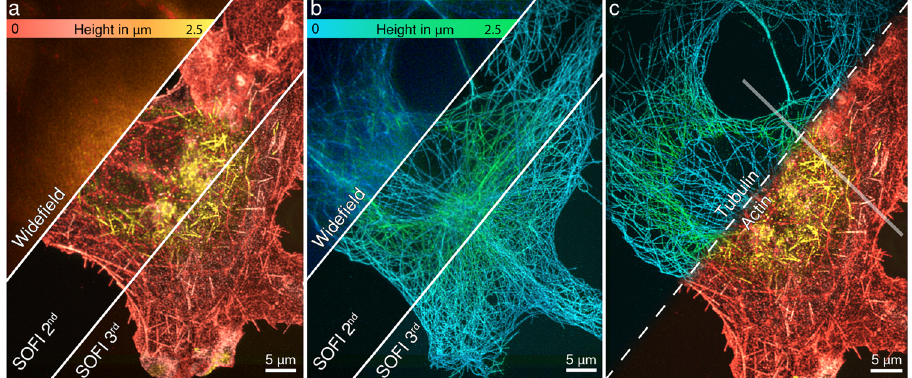
Fig. 3 Multi-plane 3D SOFI imaging of cytoskeletal components in a fi xed COS-7 cell. a 3D SOFI imaging of fi lamentous actin labeled with phalloidin conjugated to Alexa-647 and tubulin ( b ) labeled with the Abberior FLIP-565 self-blinking dye. A sample volume of 2.45 μ m × 65 μ m × 55 μ m was recorded with 8 equally spaced physical planes, resulting in 22 image planes after 3 rd order SOFI processing. Flat- fi elded 635 nm and 532 nm laser lines were used for the excitation. Alexa-647 dye was imaged in reductive/oxidative system imaging buffer with 10 mM mercaptoethylamine, while the Abberior FLIP-565 dye was imaged in a 50% glycerol and PBS solution at pH = 7.5. Height is represented in color scales displayed for each channel. c Co-registered 3D 3 rd order SOFI volumes of tubulin and fi lamentous actin. Co-registration was performed based on bright fi eld microscopy images acquired after recording each fl uorescence channel. Semi-transparent line shows the cross-sections displayed in Fig. 5 ( a , b ). This fi gure is representative of more than 10 two-color 3D SOFI images obtained from at least two independent